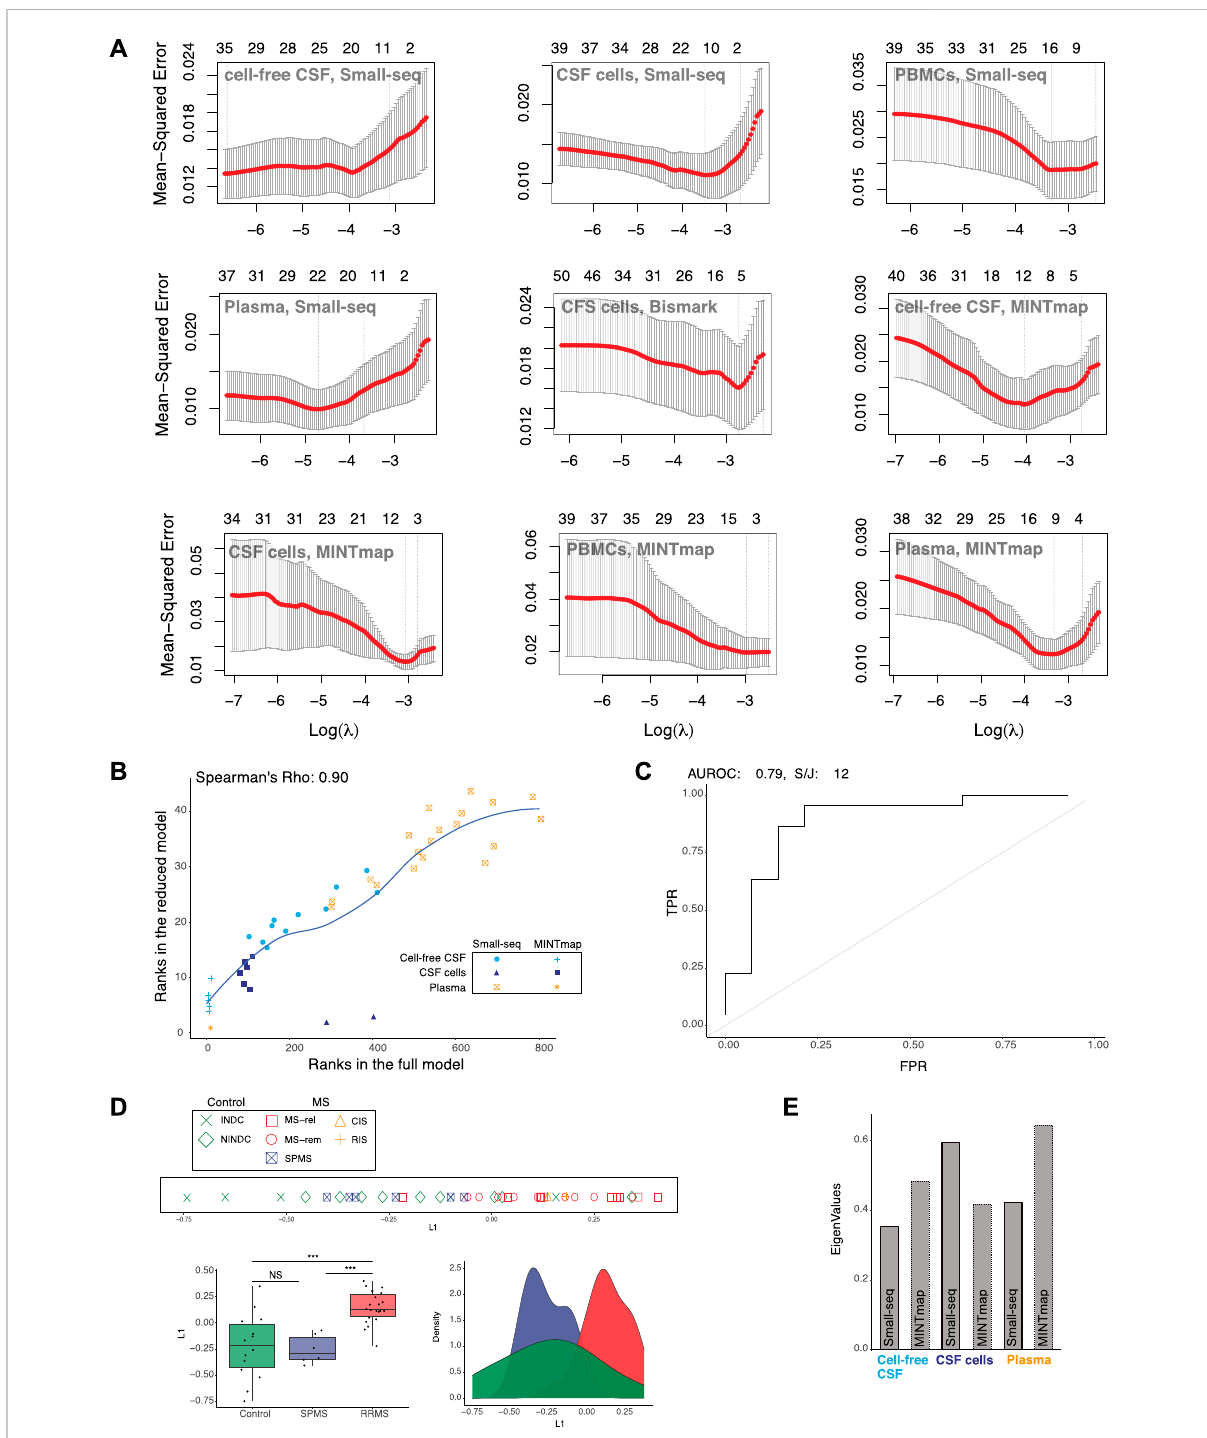
FIGURE 3 RRMS separation from controls and SPMS remains after feature reduction. (A) Lasso regression. Lambda parameter tuning of small RNA data processed through Small-seq and MINTmap pipelines from cell-free cerebrospinal fl uid (CSF), CSF cells, plasma and peripheral blood mononuclear cells (PBMCs) as well as methylome data from CSF cells processed through the Bismark pipeline, which were included in the initial, full multiple co- inertia analysis (MCIA)model. (B) Scatter plot comparing ranks of the 44 selected features with ranks of the full model (limited to 800). Dots are color-codedandshaped according to cellularand fl uidcompartment(CSF: cerebral spinal fl uid, CSF cellsand plasma) and Small-seq andtransfer(t) RNA fragments (tRFs)), respectively. (C) Area Under the Receiver Operating Characteristics (AUROC) and k-means clustering (k = 2) followed by split